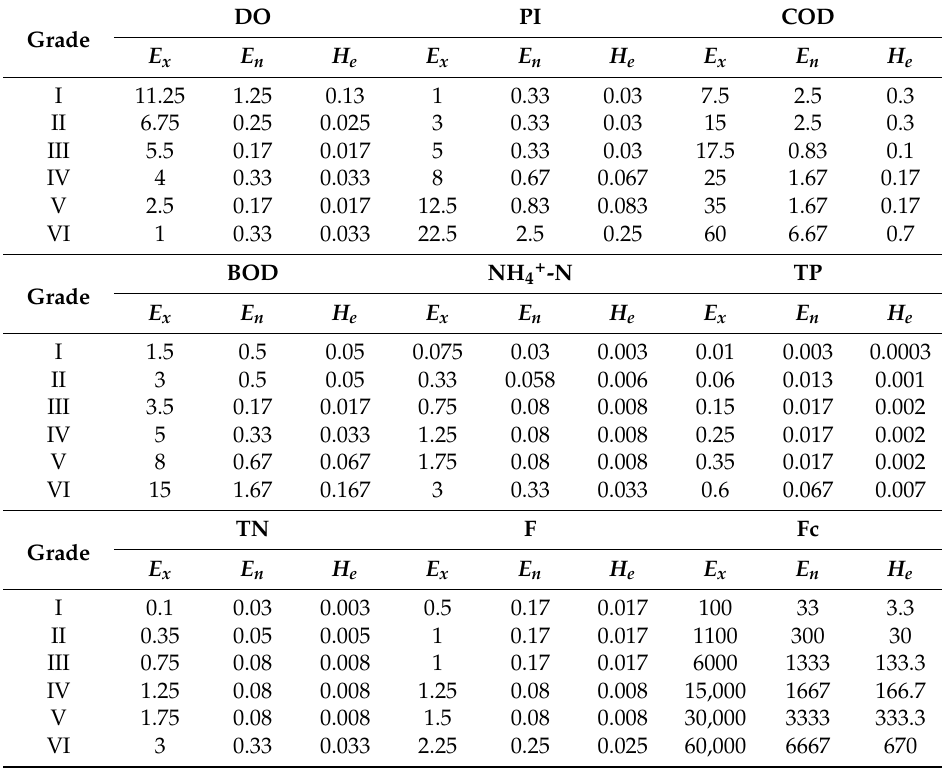
Table 2. Cloud model parameters of water quality grades of all